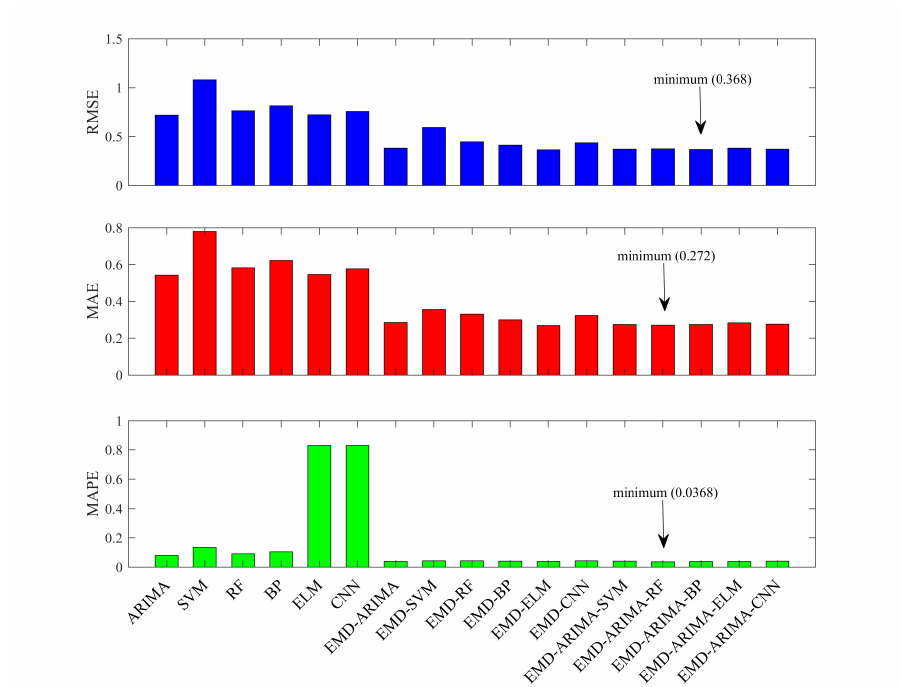
Figure 8. Wind speed prediction comparisons for the 10 min data at the GS site.